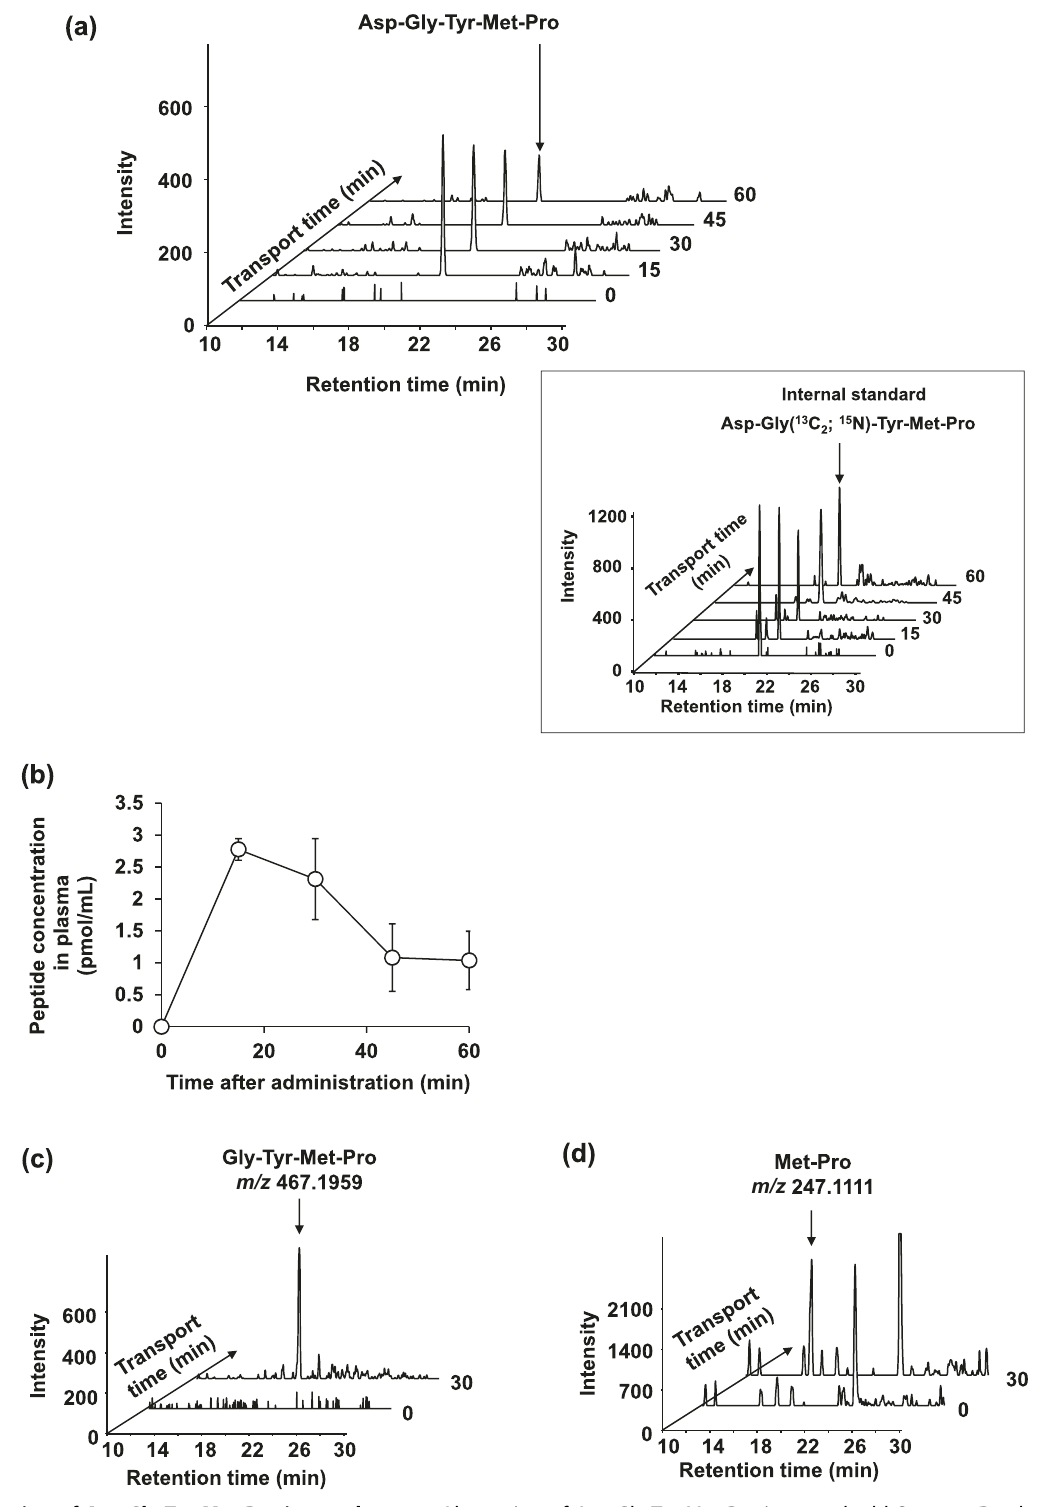
Fig. 3 Absorption of Asp-Gly-Tyr-Met-Pro in rat plasma. a Absorption of Asp-Gly-Tyr-Met-Pro in 8-week-old Sprague-Dawley rats. Stacked intensity-time chromatograms of Asp-Gly-Tyr-Met-Pro with [M + H] + of m / z 582.2228 and 50 pmol/mL of labeled internal standard (IS) Asp-Gly ( 13 C 2 ; 15 N)-Tyr-Met-Pro ([M + H] + : m / z 585.2228) (insert) created by sampling plasma at 0, 15, 30, 45, and 60 min from tail veins of rats dosed with 100 mg/kg BW Asp-Gly-Tyr-Met-Pro. b Time course of appearance of Asp-Gly-Tyr-Met-Pro in plasma of rats orally administered with 100 mg/kg BW determined by LC – TOF/MS. Data are expressed as means ± SEM ( n = 5). c , d Extracted ions corresponding to those of possible metabolites, Gly-Tyr-Met-Pro ([M + H] + : m / z 467.1959) and Met-Pro ([M + H] + : m / z 247.1111) were detected in rat plasma at 30 min after